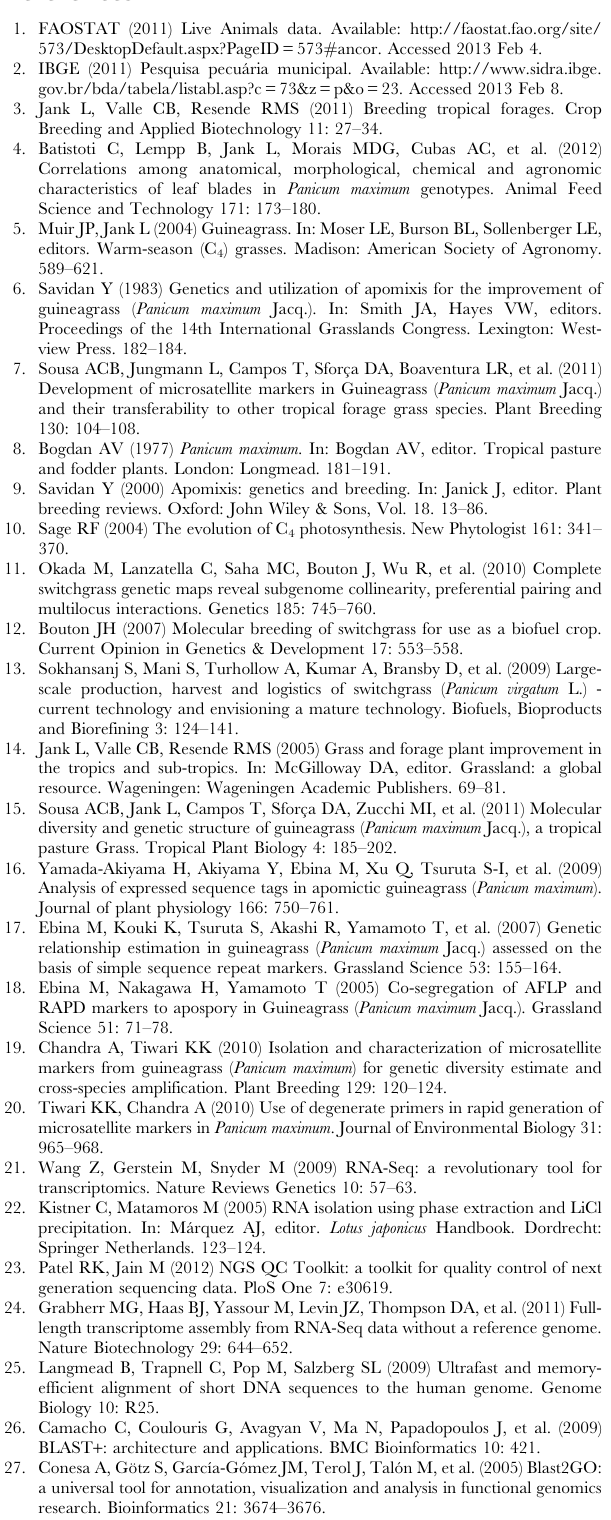
(TIF) Table S1 Statistics of sequenced data for each P. maximum